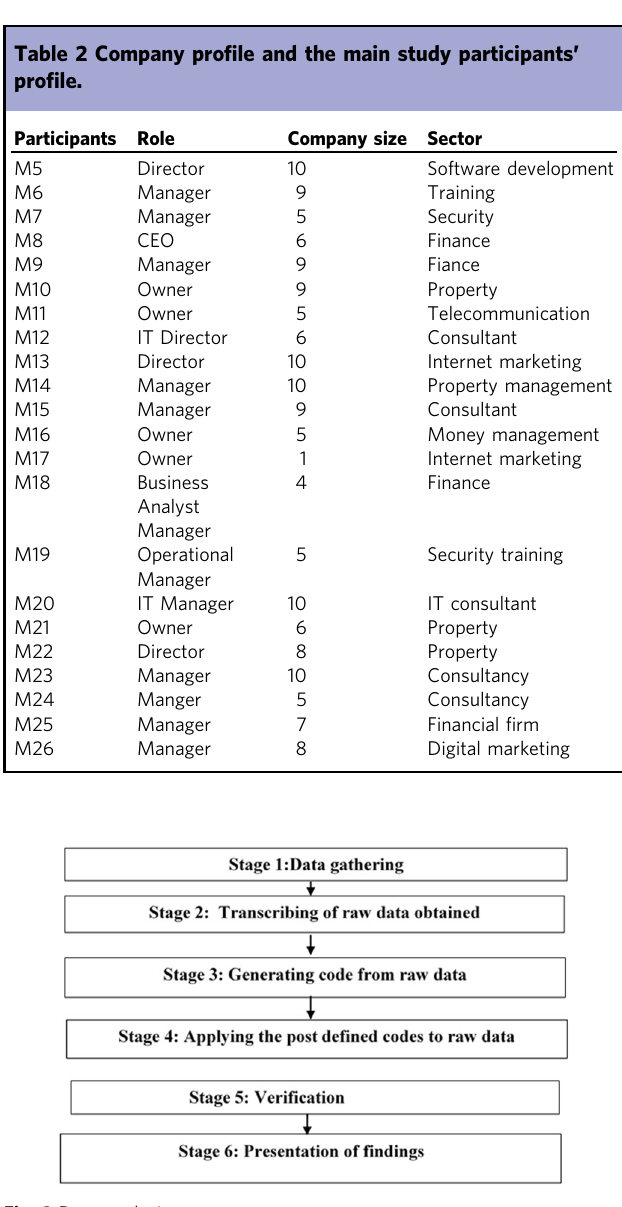
Fig. 2 Data analysis